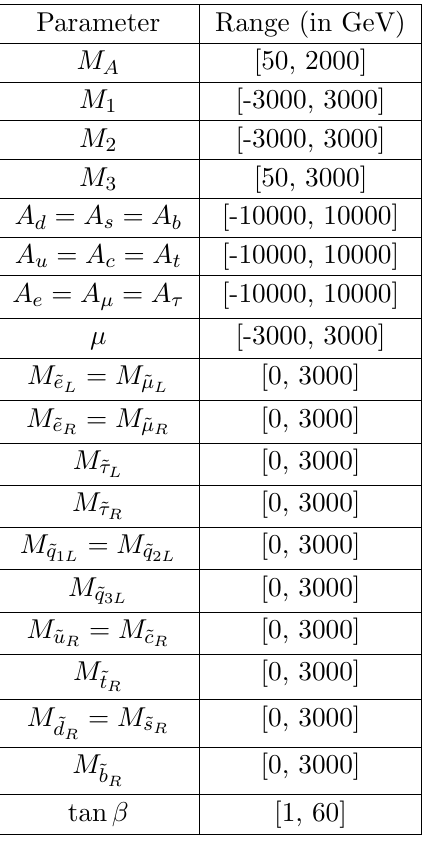
Table 3 . pMSSM scan